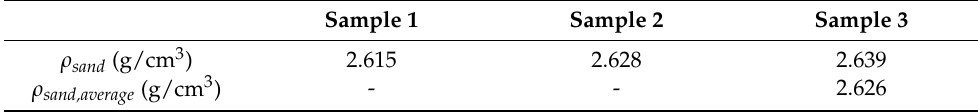
Table 1. Density value of